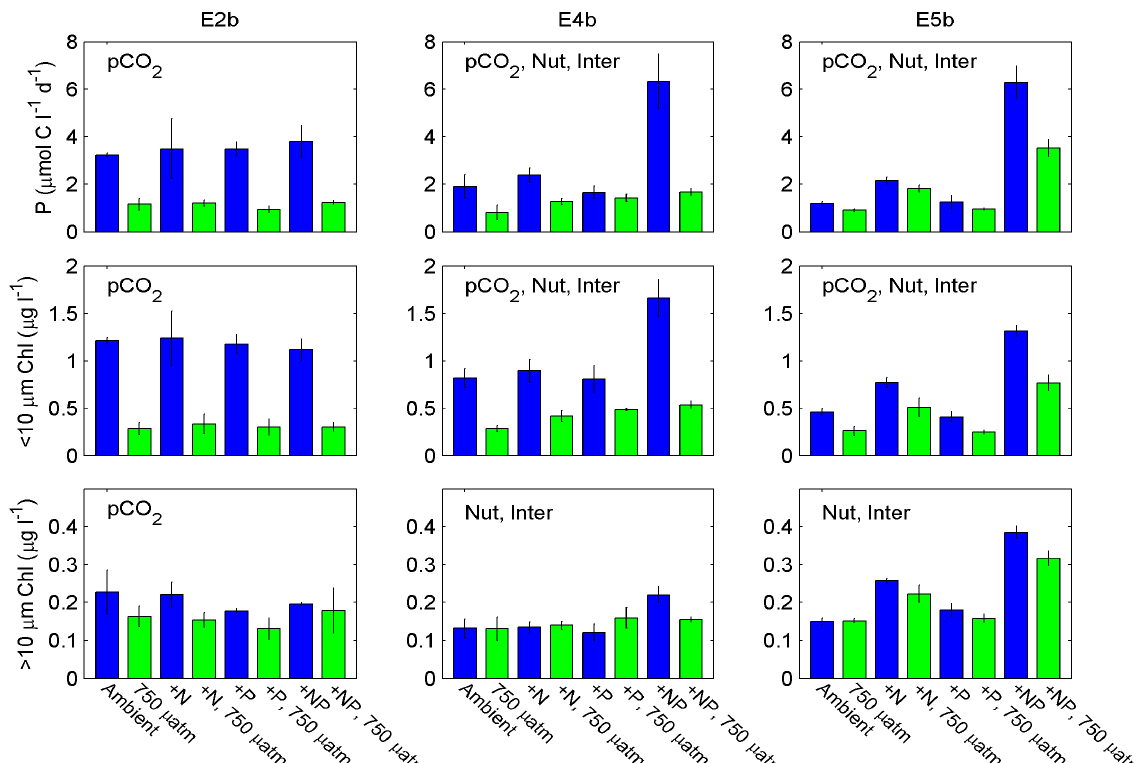
Figure 10. Primary production (µmolCL − 1 d − 1 ) (top), < 10µm size-fractionated Chl a (middle) and > 10µm size-fractionated Chl a (µgL − 1 ) (bottom) from the additional combined macronutrient and carbonate chemistry manipulation experiments (E2b, E4b and E5b). Data are presented as means ± 1SE of biological triplicates for each variable after 24h incubation under ambient or 750µatm p CO 2 (colours as in Fig. 7) and under either unamended or nutrient-amended ( + N, + P and + NP) conditions. Individual panels are annotated with the results of a two-way ANOVA, with “ p CO 2 ”, “Nut” and “Inter” indicating significant ( p < 0.05) differences between factors corresponding to the imposed perturbation of the carbonate system, macronutrients and an interaction between these factors respectively.